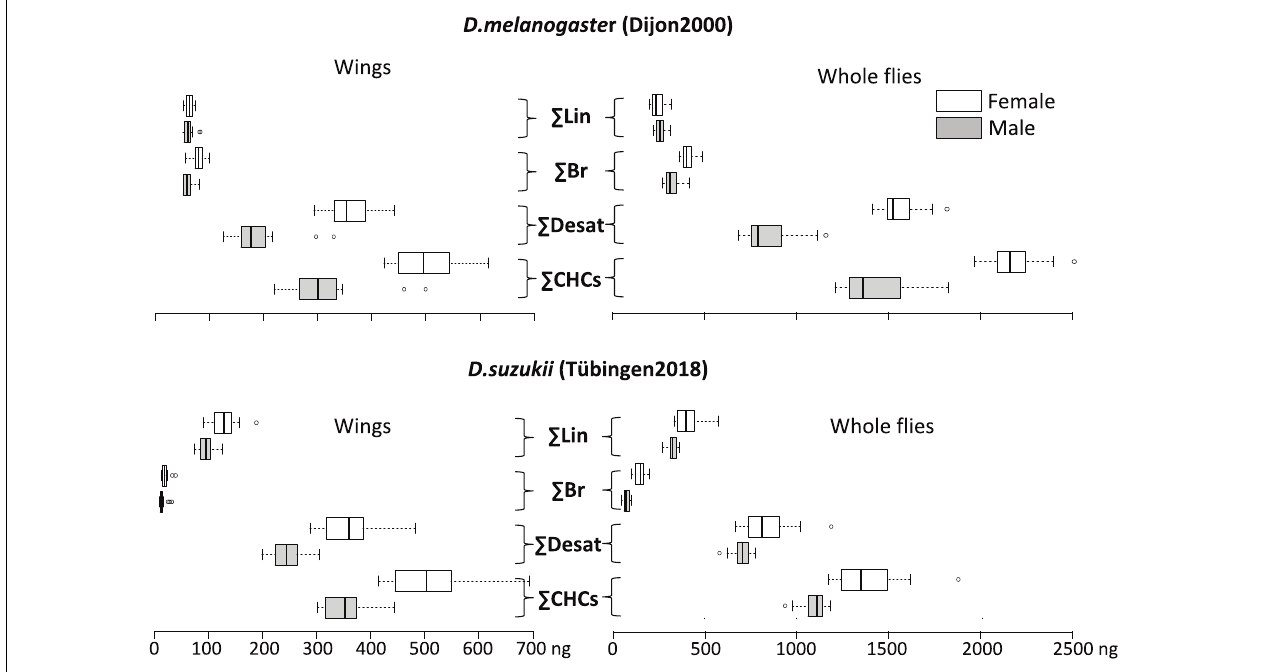
FIGURE 4 | Amounts (in ng) and composition of wings (left panels) and whole body (right) CHCs in individual D. melanogaster (top) and D. suzukii (bottom) were determined by gas chromatography and mass spectrometry. The amounts of sum linear ( (cid:54) Lin), sum branched ( (cid:54) Br) and sum desaturated ( (cid:54) Desat) CHCs were calculated based on the overall sum of CHCs ( (cid:54) CHCs). See Supplementary Figure S2 for all detected CHCs and Table 3 for the statistical analysis of these data.